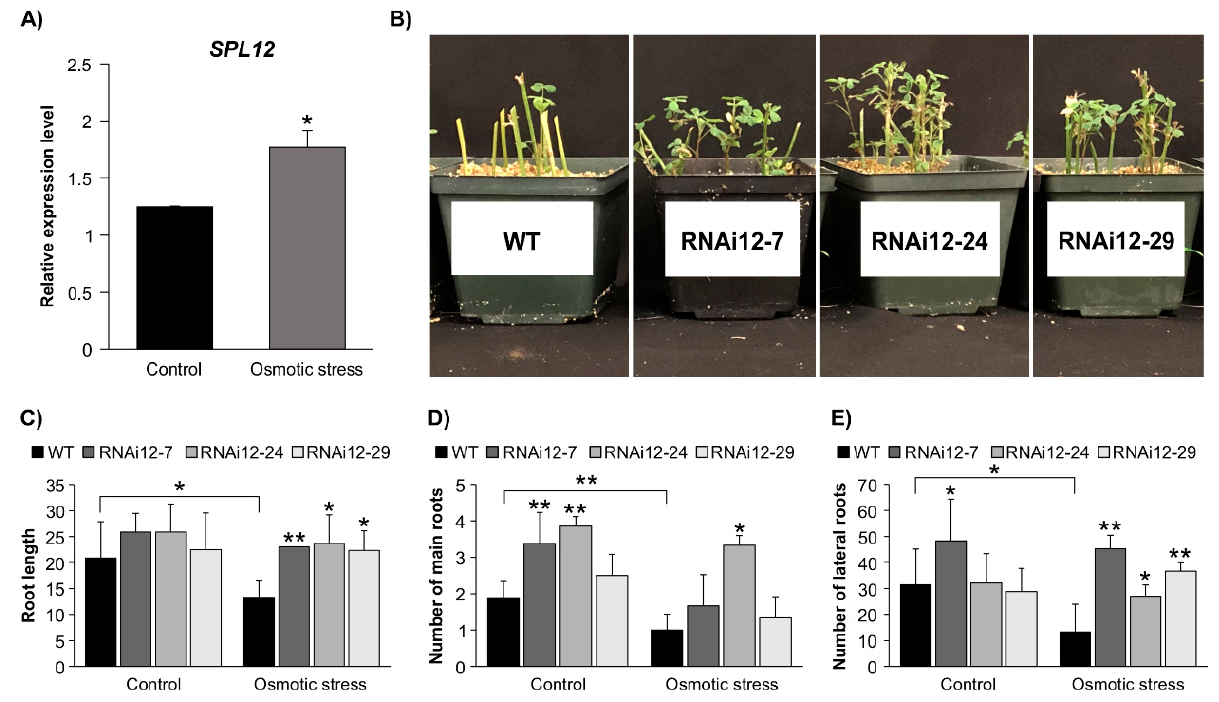
Figure 5. Effect of SPL12 silencing on response to osmotic stress. ( A ) Relative SPL12 transcript levels of WT alfalfa treated with mannitol (400 mM) n = 3; ( B ) representative WT and SPL12 -RNAi plants that were treated with mannitol (400 mM) for three weeks; ( C ) root length; ( D ) number of main roots; and ( E ) number of lateral roots of WT and SPL12 -RNAi alfalfa under control and osmotic stress conditions (n = 11–14). * and ** indicate significant differences relative to WT using Student’s t -test p < 0.05, p < 0.01, respectively. Error bar indicates standard